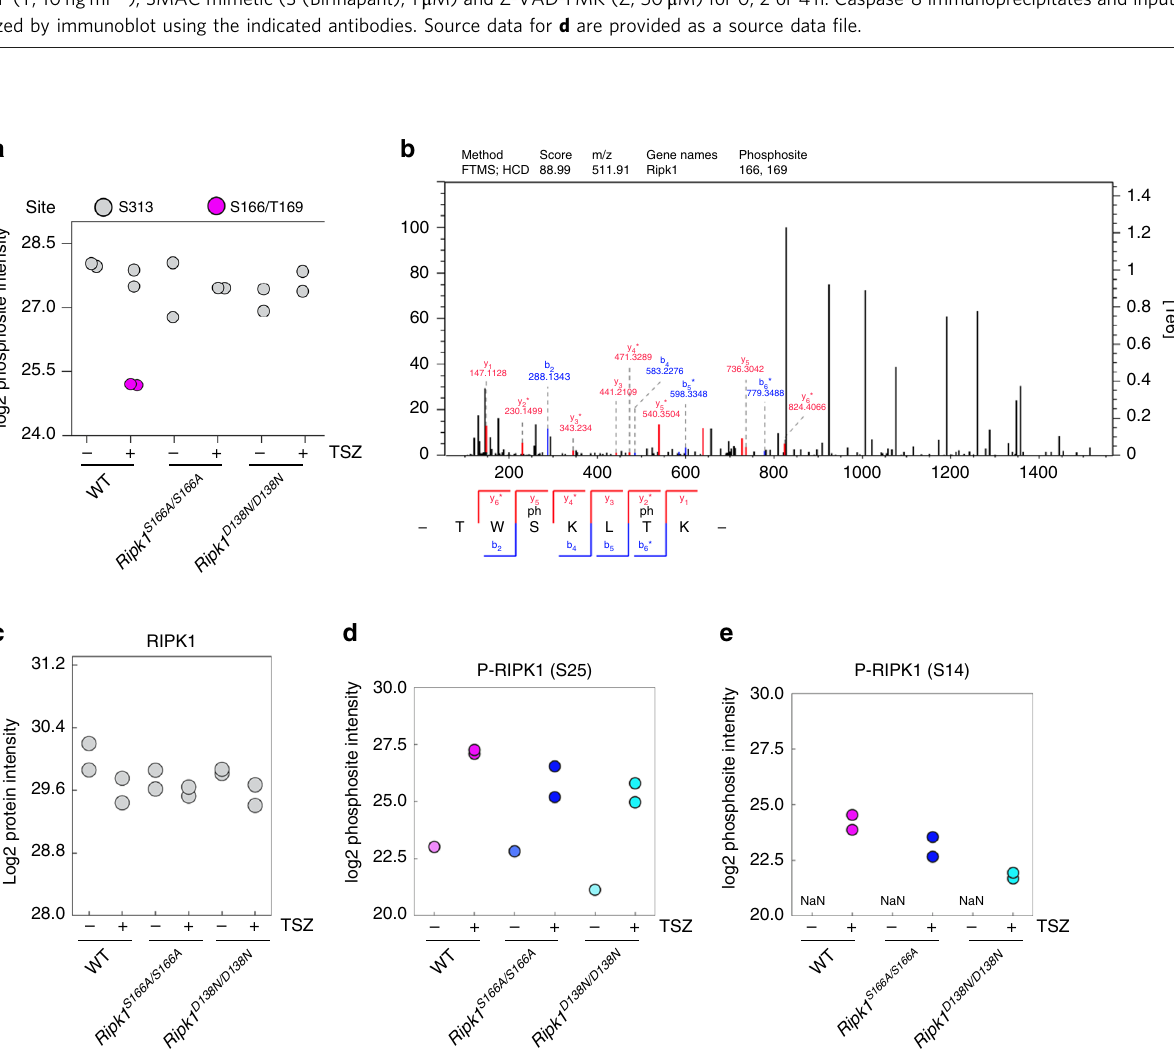
Fig. 7 S166 phosphorylation enhances RIPK1 kinase activity. a Scheme depicting the possible combinations of RIPK1 dimers in Ripk1 D138N/S166A mice. Residue 166 on RIPK1 is indicated. b , BMDMs from mice of the indicated genotypes were treated with a combination of TNF (T; 10 ng ml − 1 ), SMAC mimetic (S (Birinapant), 1 μ M) and Z-VAD-FMK (Z) for 0, 2 or 4 h and lysates were analyzed by immunoblot with the indicated antibodies. Blots shown are representative of three independent experiments. *Non-speci fi c band. c Primary lung fi broblasts from mice of the indicated genotypes were treated with a combination of TNF (T; 20 ng ml − 1 ), SMAC mimetic (S (Birinapant), 1 μ M) and Z-VAD-FMK (Z) for 0, 3 or 5 h and lysates were analyzed by immunoblot with the indicated antibodies. Blots shown are representative of three independent experiments. d BMDMs from mice of the indicated genotypes were treated with combinations of TNF (T; 10 ng ml − 1 ), SMAC mimetic (S (Briniapant), 1 μ M) and Z-VAD-FMK (Z) in the presence or absence of Nec-1s. Cell death was measured using IncuCyte. Graph shows mean of technical triplicates. Data are representative of three independent experments. For purpose of comparability the data of the genotypes WT, Ripk1 S166A/S166A and Ripk1 D138N/D138N shown here are identical to those in Fig. 1b.